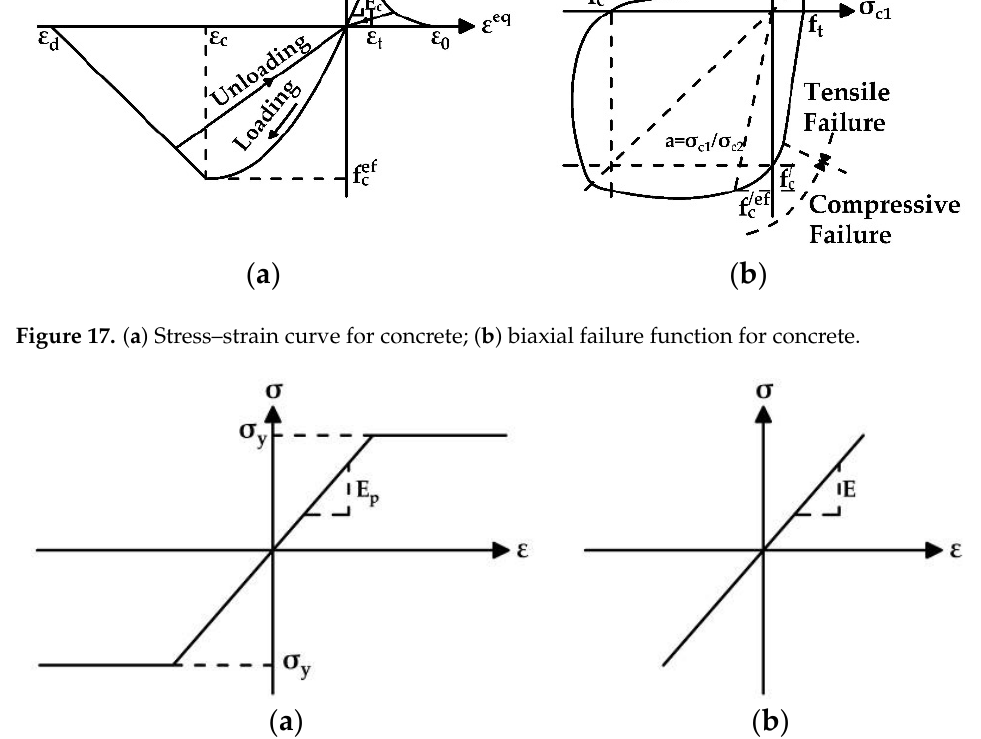
Figure 18. ( a ) Stress–strain curve for prestressing steel; ( b ) stress–strain curve for saw-cuts. Normal stress values were determined in nine monitoring points over a total length of 50 mm, which expresses the length of the measuring grid of the used strain gauges during the experimental campaign. Subsequently, the normal stress relief ( ∆ σ c ) was calculated as the average value from all individual monitoring points. The initial normal stress values ( σ c,0 ), normal stress values after the application of saw-cuts with a depth of 30 mm ( ∆ σ c,30 ), and values of normal stress relief ( ∆ σ c ) are listed in Table 3. According to numerical analysis, the total value of normal stress relief was − 4.49 MPa. Results of the nonlinear numerical analysis suggest that the performed saw-cuts (axial distance of 120 mm, depth of 30 mm) initiated circa 80% stress relief. This agrees with the findings of the parametric study presented in [31] or in [32]. The distribution of normal stress in the area adjacent to the performed saw-cuts is shown in Figure 19. Table 3. Normal stress values from numerical analysis performed in ATENA 2D Software.